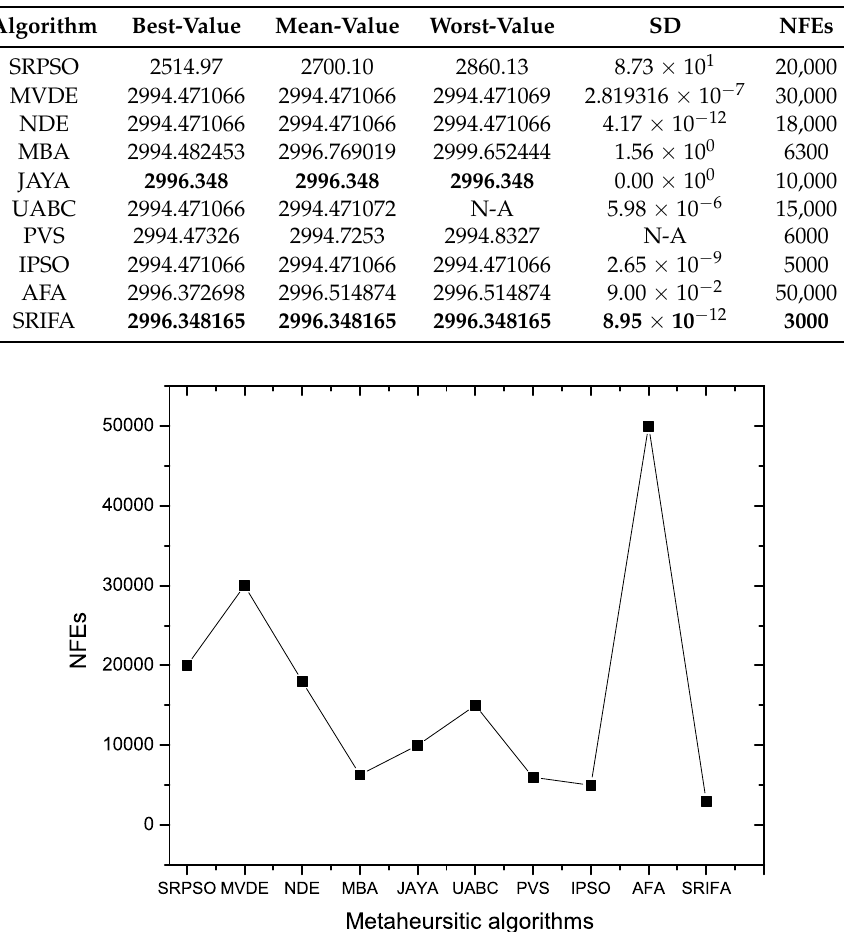
Figure 10. NIAs with NFEs for the speed-reducer